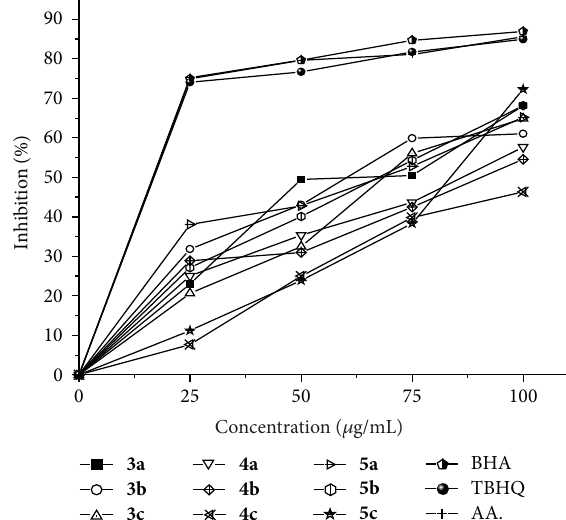
F 1: RSA of compounds 3a-c , 4a-c and 5a-c .